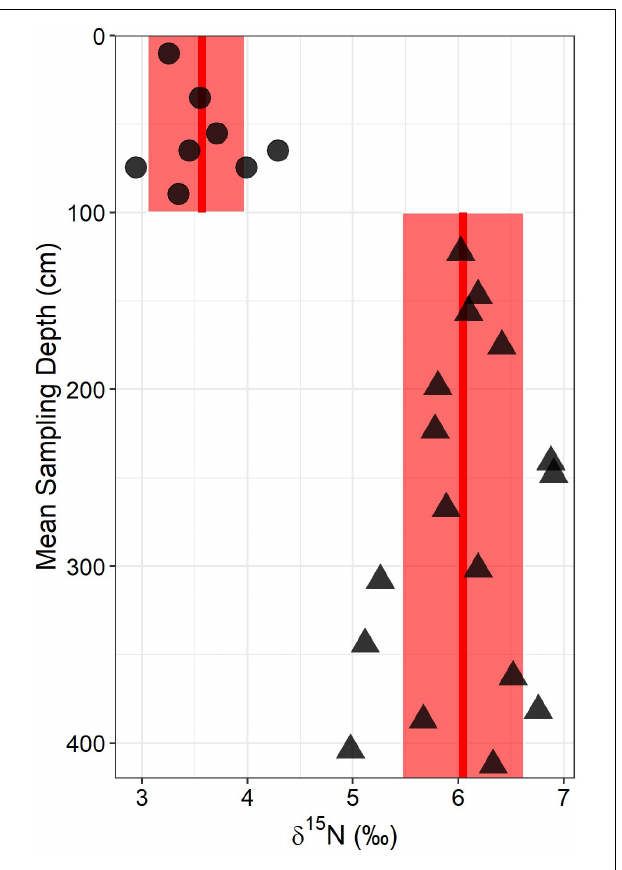
FIGURE 6 | Total soil- δ 15 N depth profile for the ridgecrest location. Circles represent soil (0–100 cm) samples whereas triangles represent saprolite and bedrock samples ( > 100 cm). Red lines and shaded boxes indicate mean values and ± one standard deviation from the mean for the two groups of points. Points at the same depth reflect sampling of horizons where there was both shale fragments and soil present (50–60 and 60–70).